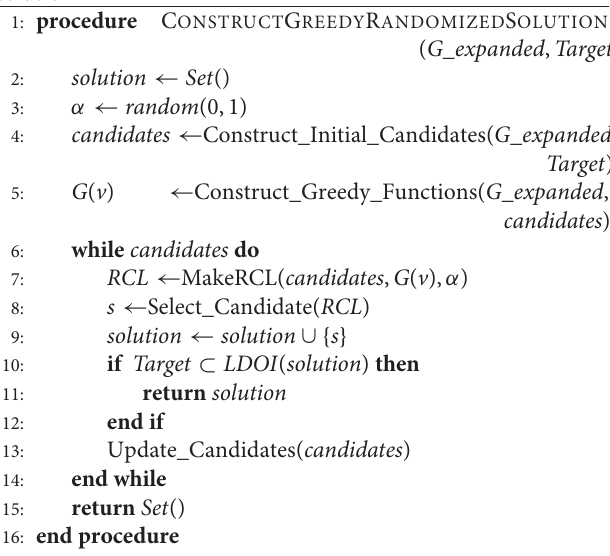
Algorithm 2 Algorithm for constructing a greedy